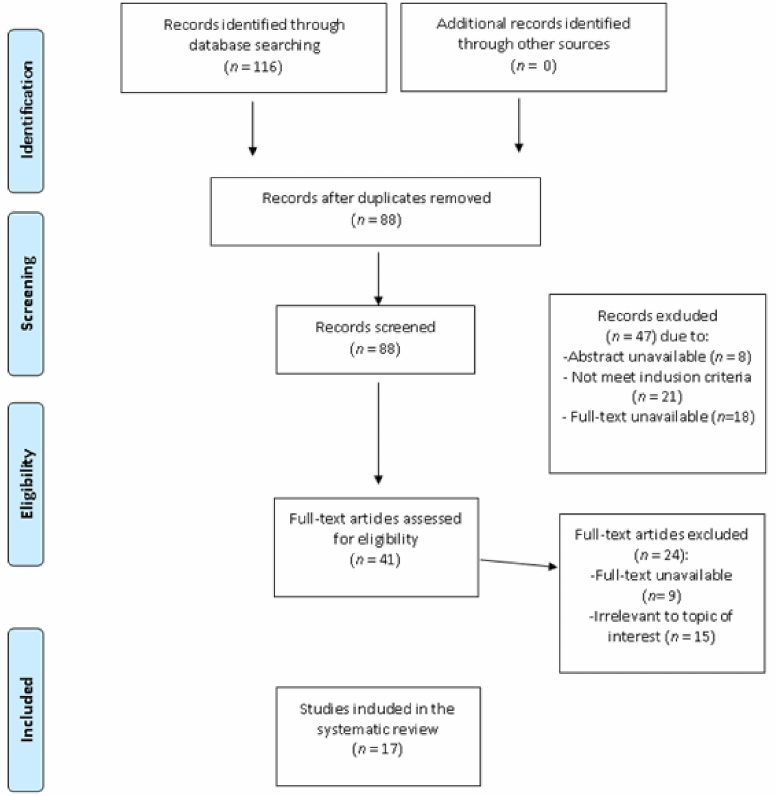
Figure 1. Prisma flowchart of information through the different phases of the